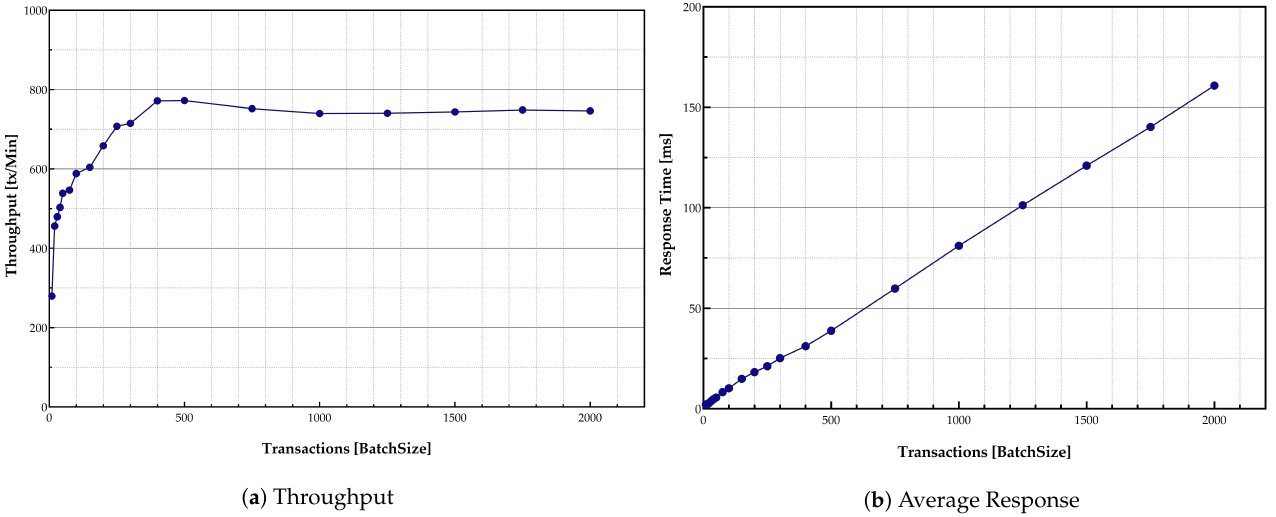
Figure 9. Effects of transaction sizes on the throughput and average response times in Raspberry Pi